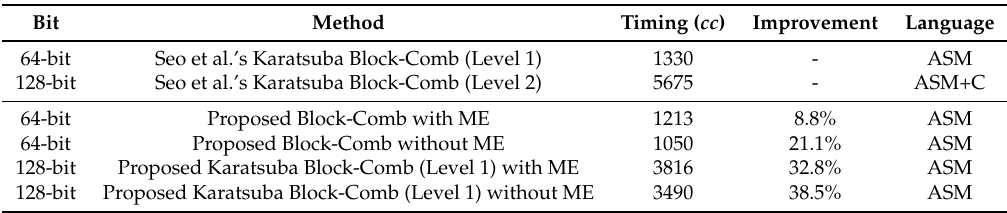
Table 2. Timing analysis and comparison for the proposed SCA-resistant 64-bit, and 128-bit wise BF multiplication (the cost includes the overhead for function calls, such as POP and PUSH instructions). ME means multiplier encoding.